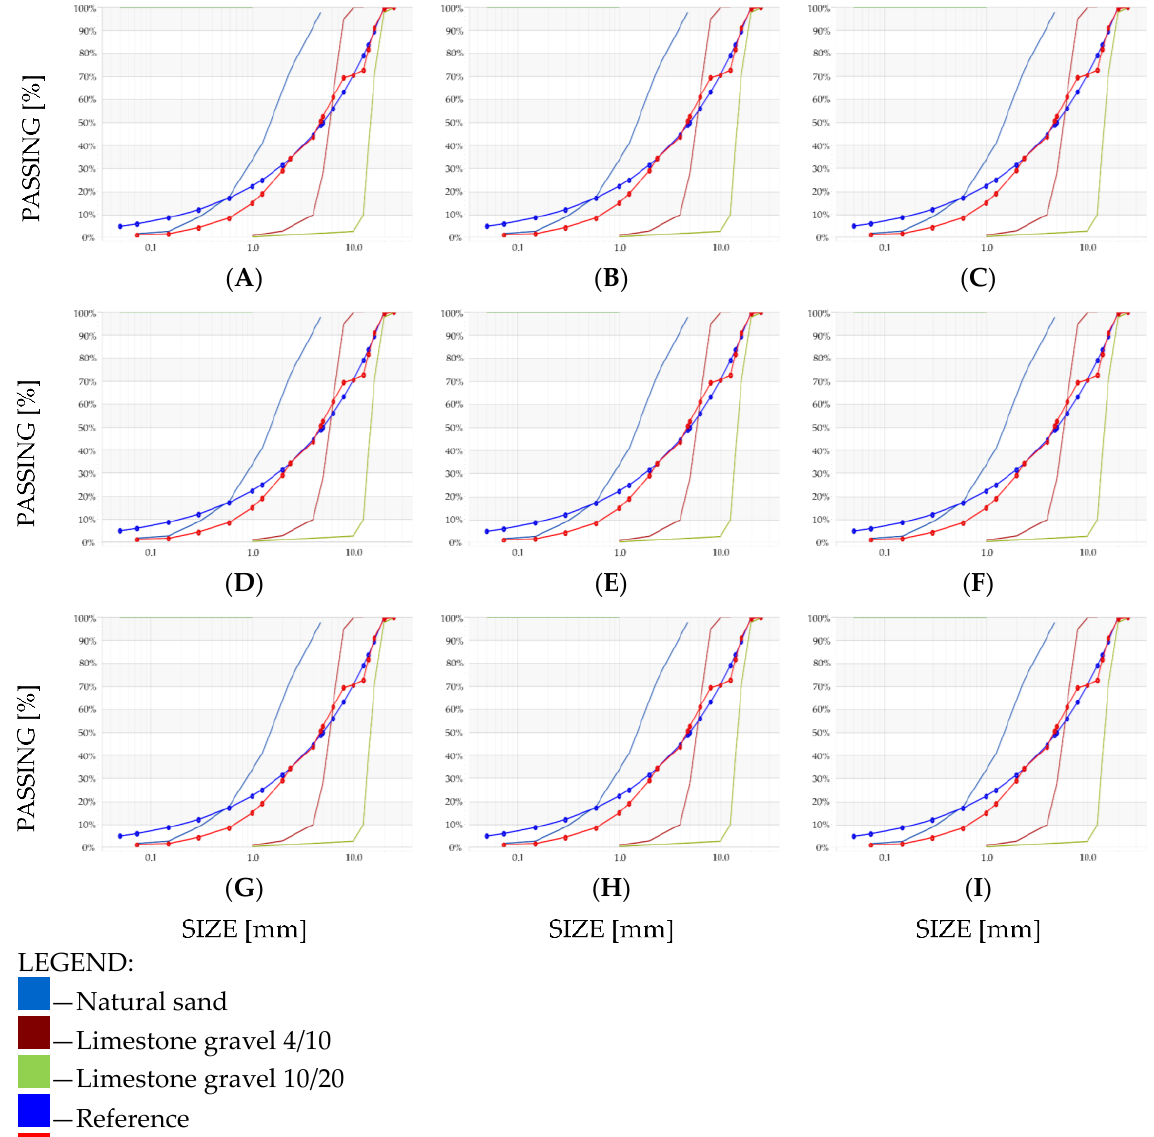
Figure A2. Gradings and fitting curves for Recipe #1—standard mix with plasticizer (lignosulfonate) and superplasticizer (polycarboxylate ether) designed according to the Fuller Method: ( A ) 10 MPa; ( B ) 15 MPa; ( C ) 20 MPa; ( D ) 25 MPa; ( E ) 30 MPa; ( F ) 35 MPa; ( G ) 40 MPa; ( H ) 45 MPa; ( I ) 50 MPa. Legend in the left bottom